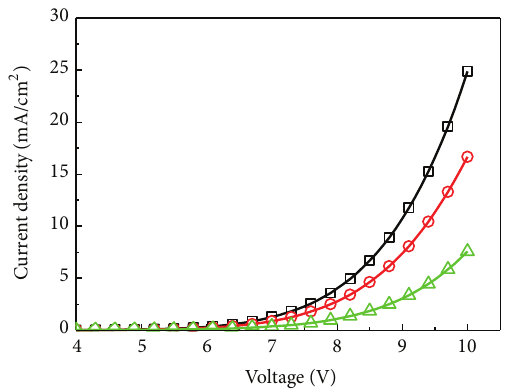
Figure 2: Current density versus bias voltage characteristics of electron-only devices with a Bebq 2 layer deposited at three depo- sition rates (solid line, 0.03 nm/s; dashed line, 0.3 nm/s; dotted line, 1.3 nm/s).